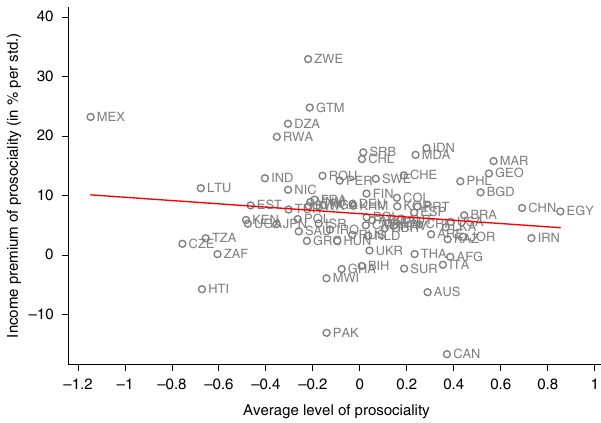
Fig. 3 The relationship between income premia of prosociality and log GDP per capita. The red line indicates the prediction from a linear regression. Spearman correlation: − 0.065 ( p =